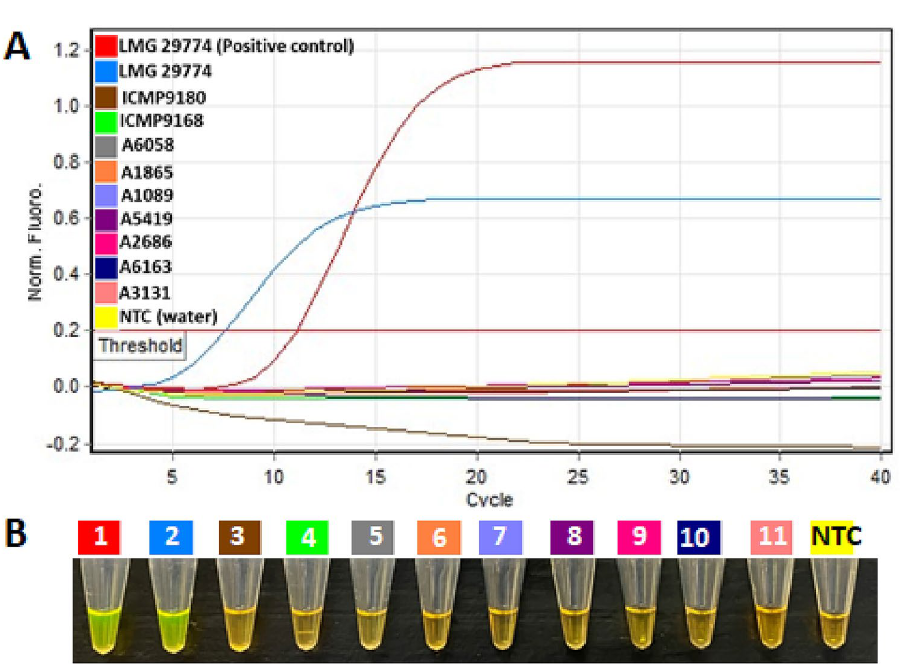
Figure 3. Specific detection of Pectobacterium parmentieri using loop-mediated isothermal amplification (LAMP) assay from heat-killed bacterial cells. ( A ) Real-time amplification plot, no sigmoidal curve was observed with strains of exclusivity panel and non-template control; ( B ) visualization of LAMP products after adding 3 μl of SYBR Green I stain. 1- Positive control DNA ( P. parmentieri LMG29774), 2–11 heat-killed colonies: P. parmentieri (LMG29774), P. polaris (ICMP 9180), P. versatile (ICMP 9168), D. dianthicola (A6058), Pantoea sp. (A1865), P. odoriferum (A1089), D. dadantii (A5419), P. odoriferum (A2686), P. atrosepticum (A6163), Klebsiella aerogene (A3131), and negative template control (NTC,